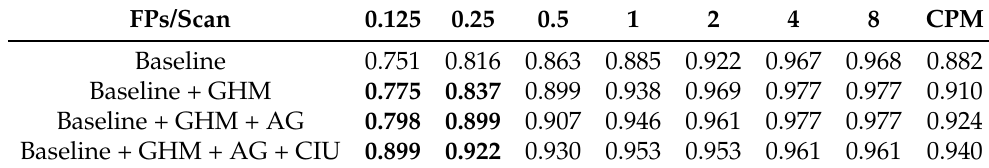
Table 4. Results of the ablation study on LUNA2016.